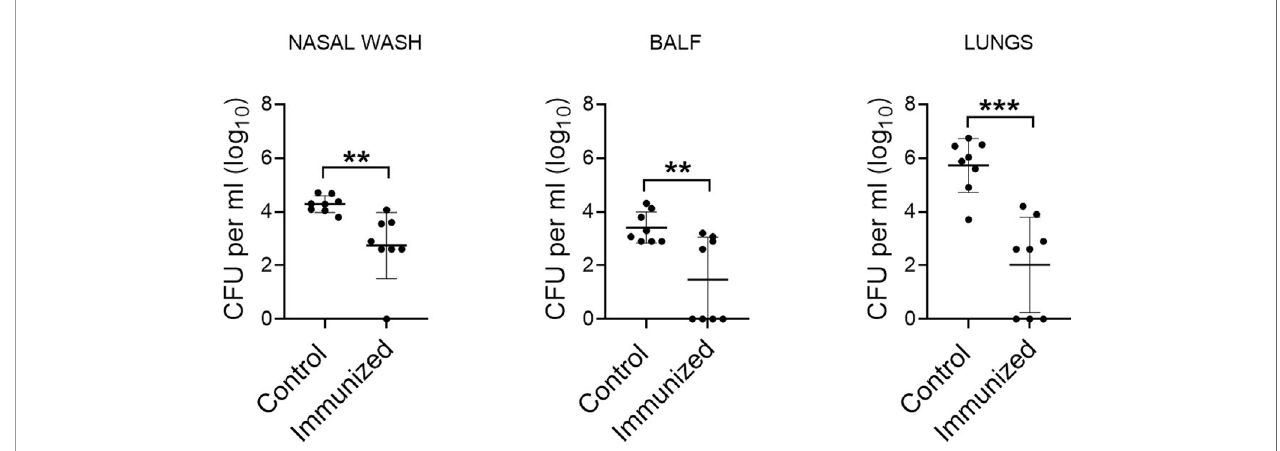
FIGURE 1 | Protective ef fi cacy of S. mitis serotype 5 against lung infection with pneumococcal serotype 5. Mice were intranasally immunized with S. mitis serotype 5 or PBS (control) at days 0, 14, and 21, and then subjected to lung infection with S. pneumoniae serotype 5. They were sacri fi ced at 24 hours following the challenge infection, and nasal wash, BALF, and lungs were collected for the analysis of pneumococcal load (CFU). Data are shown as mean ± SD and pooled from the results of two independent experiments with 4 mice in each group. Each symbol represents data from an individual mouse, and the horizontal bars are mean values of the groups. **p<0.01; ***p<0.001. Unpaired Student ’ s t test.